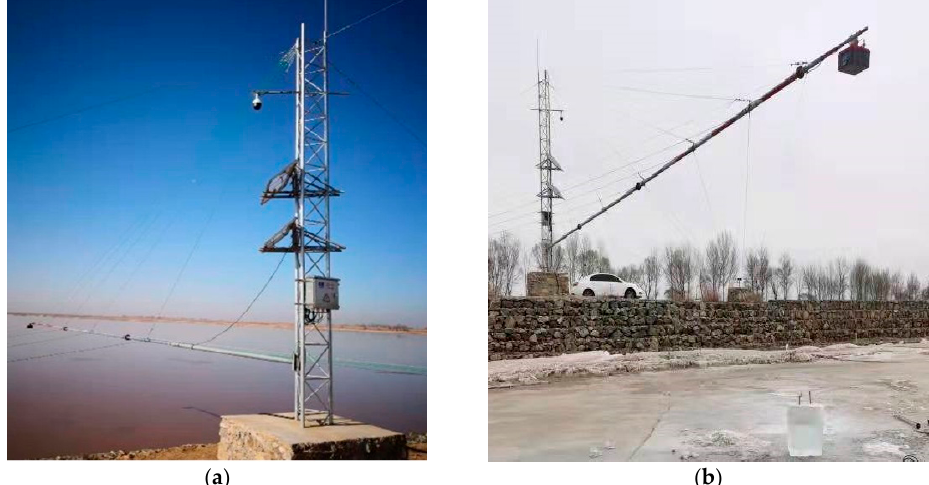
Figure 4. Site drawing of installed equipment. ( a ) Radar equipment from bank view; ( b ) radar equipment from river view.